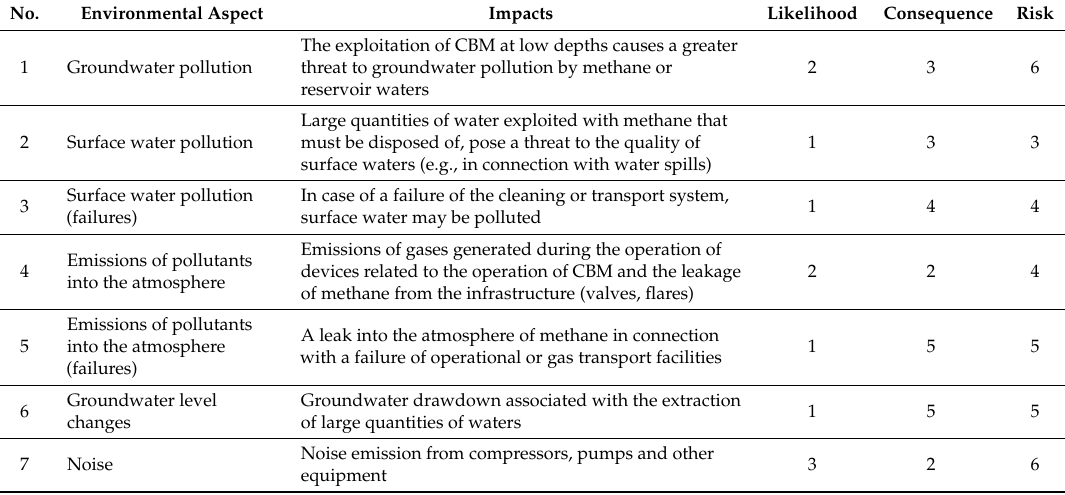
Table 2. Environmental impact and risk resulting from CBM exploitation.